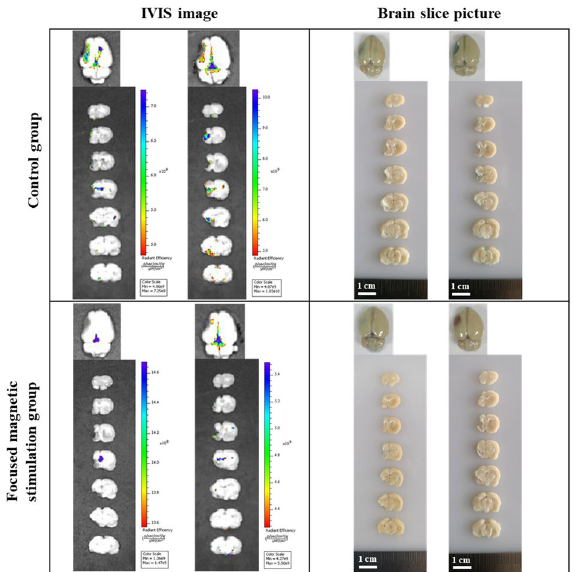
Figure 4. IVIS image and slice picture of stroke model. Brain damage due to stroke shows irreversible histological damage. Therefore, focused heating induces functional recovery by stimulating the remaining tissue around the lesion. By applying focused heating to the stroke model (n = 6), additional damage to the lesion while inducing nerve stimulation was evaluated. In stroke models, the BBB was destroyed as a symptom of the stroke; although some Evans blue fluorescence was observed after 48 h, magnetic stimulation did not result in further deterioration. In all groups, the transient increase in BBB permeability induced by hyperthermia was safely recovered over time.